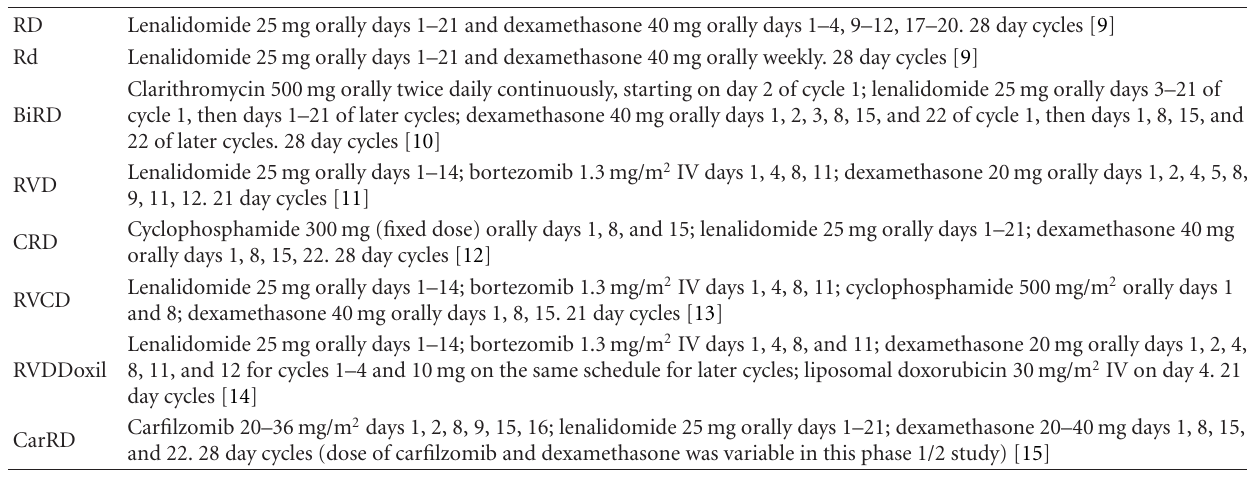
Table 1: Select lenalidomide-based, pre-ASCT induction regimens for